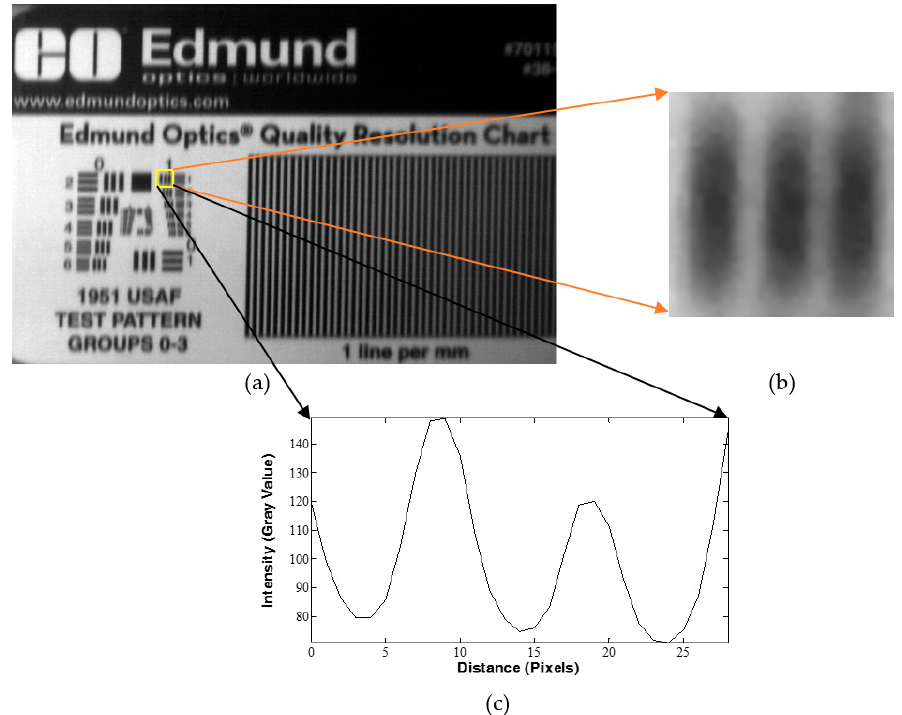
Figure 4. ( a ) A resolution (USAF-1951) target is imaged by the AOTF-HSI system at 700 mm displacement. Group-1/element-1—zoomed in ( b )—is enclosed in a yellow dotted rectangle. ( c ) The intensity was plotted, where maximum and minimum intensities are identified to calculate the contrast transfer function (CTF) at this range.